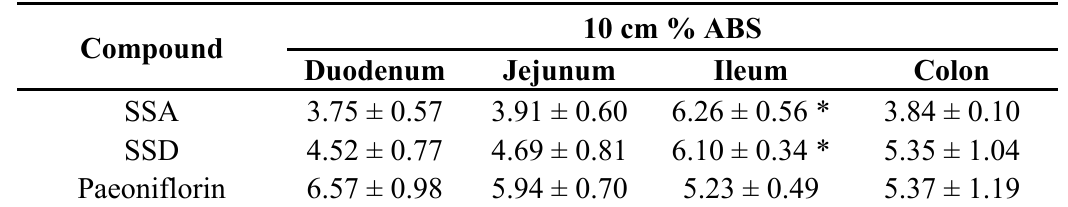
Table 2. 10% ABS of SSA, SSD and paeoniflorin in different intestinal segments ( x ± s, n =